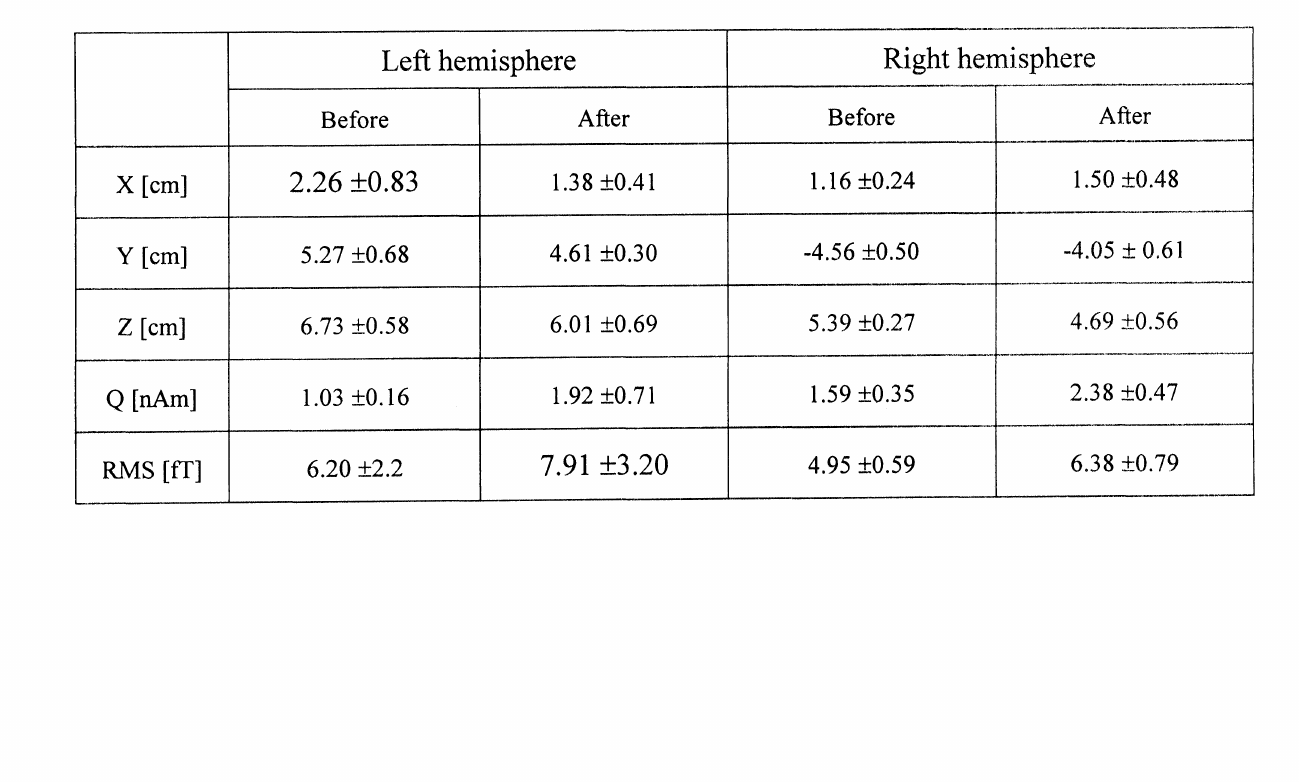
Locations of the gamma-band equivalent sources (means _+ standard error of the mean) obtained in measurement sessions before and after virtual pitch